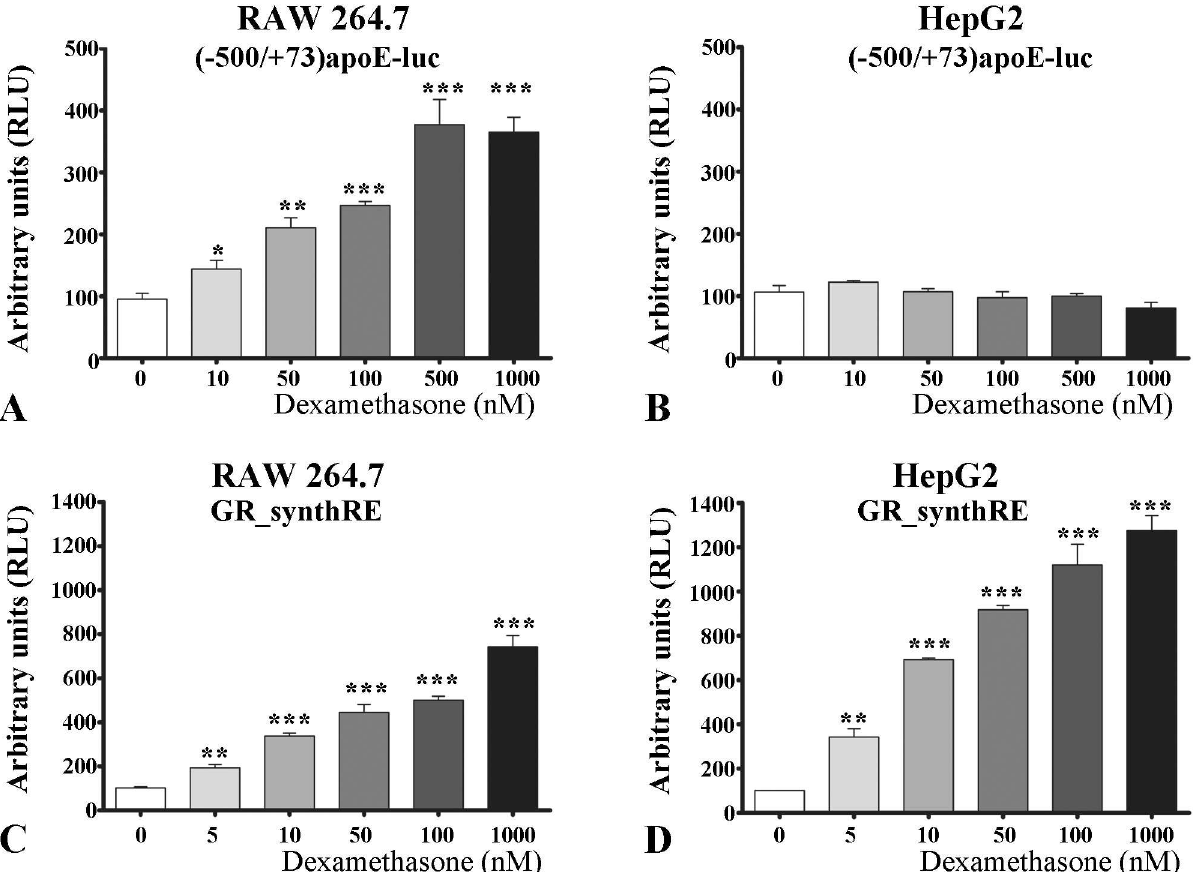
Fig 5. Transactivation of apoE proximal promoter by dexamethasone in macrophages. RAW 264.7 (A, C) and HepG2 (B, D) cells were transiently transfected using plasmidscontainingapoE proximal promoter([-500/+73]apoE-luc) or a minimalpromoterwith glucocorticoid responsiveelements(GR_synthRE) and subsequently treated with increasing concentrations of dexamethasone (10–1000 nM) for 24 hours. The activities of [-500/+73]apoE-lucand GR_synthRE constructs were determinedby luciferase assays. In RAW 264.7 macrophages, dexamethasone enhances the activity of apoE proximal promoterin a dose-dependent manner (A) whereasin HepG2 hepatocytes,all tested concentrations of dexamethasone (10–1000nM) do not significantly (p > 0.05)affect apoE promoter activity (B) . In both macrophages (C) and hepatocytes (D) , the activity of GR_synthRE promoteris significantly raised by dexamethasone (10–1000nM). The symbols are: *** p < 0.001, ** p < 0.01and * p <